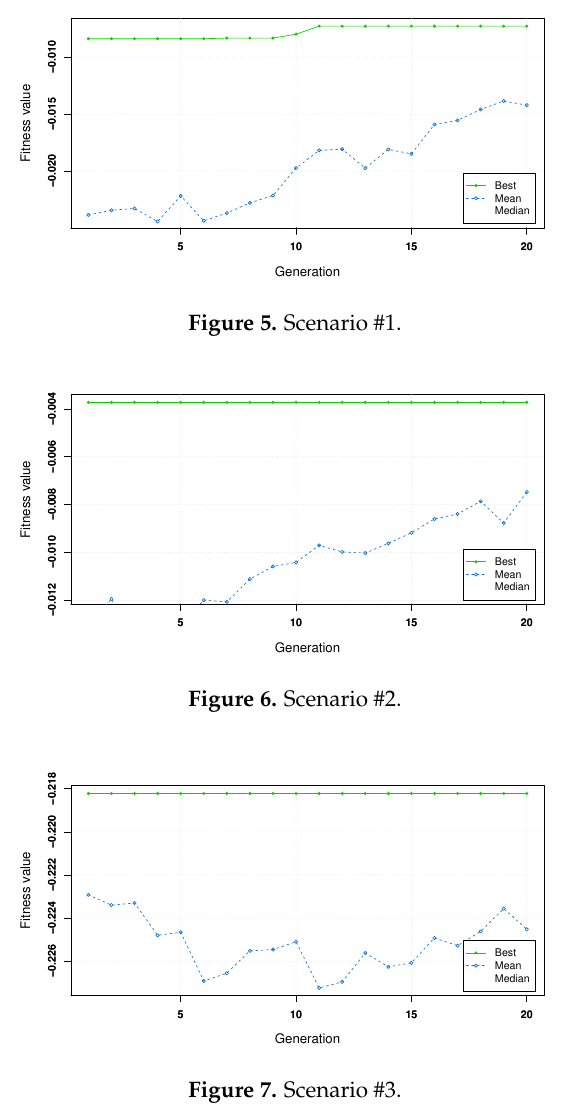
Figure 7. Scenario